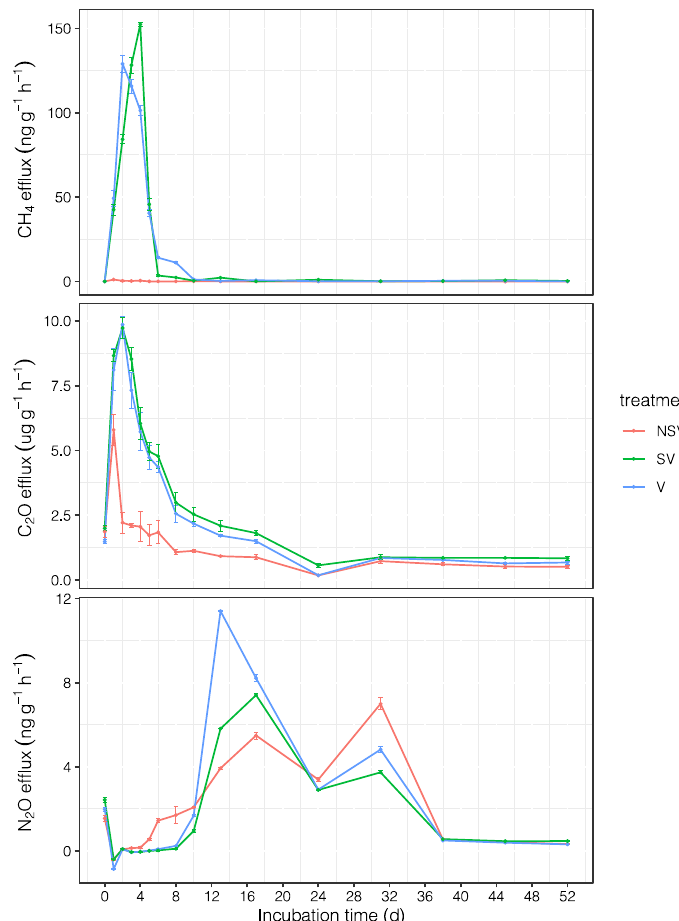
Figure 1. The daily emission dynamics of CO 2 , CH 4 , and N 2 O from the NSV, SV, and V treatments during the incubation period. NSV: no added CMV and straw; SV: added CMV and straw; V: only added CMV. Error bars represent the standard error (n = 3).